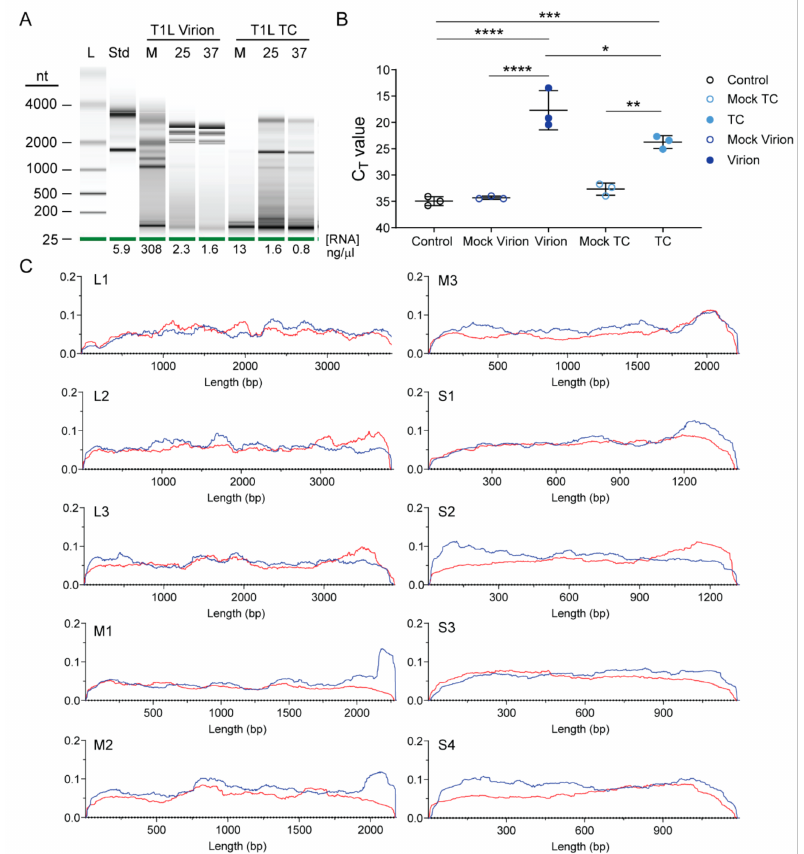
Figure 2. Enriched reovirus rsT1L TC particles package viral RNA. ( A ) Enriched rsT1L virions and TC particles were mock treated at 25 ◦ C (M) or treated with benzonase at 25 ◦ C (25) or 37 ◦ C (37) to remove extra-particle nucleic acids. RNA was extracted, quantified, and resolved on a pico RNA chip using an Agilent Bioanalyzer. Shown are electrophoresis results, with the size of the ladder (L) in nucleotides indicated. A standard (Std) indicates eukaryotic 18s and 28s rRNA peaks. RNA concentration is indicated below each lane. ( B ) S4 RT-qPCR analysis of virions and TC particles. RNA was extracted from three independent, protein normalized rsT1L virion and TC particle preparations and equal volumes of a contemporaneously purified mock virion or TC preparation. cDNA was reverse transcribed using random hexamers, and qPCR reactions were conducted in the presence of primers specific for T1L S4. Nuclease-free water was added to control reactions in the place of template RNA. Shown are raw C T values for the three independent rsT1L particle preparations or single mock preparations in triplicate. *, p < 0.05; **, p < 0.01; ***, p < 0.001; ****, p < 0.0001 by Sidak’s multiple comparison test. ( C ) Scaled Illumina read counts at each site for each segment in a representative rsT1L TC particle preparation. Segment identity and length ( x axis) in bases are shown. Multiplication of the scaled y axis factor by 1,000,000 will reveal coverage at each site in CPM for plus-strand and minus-strand reads, which are indicated by red and blue lines,